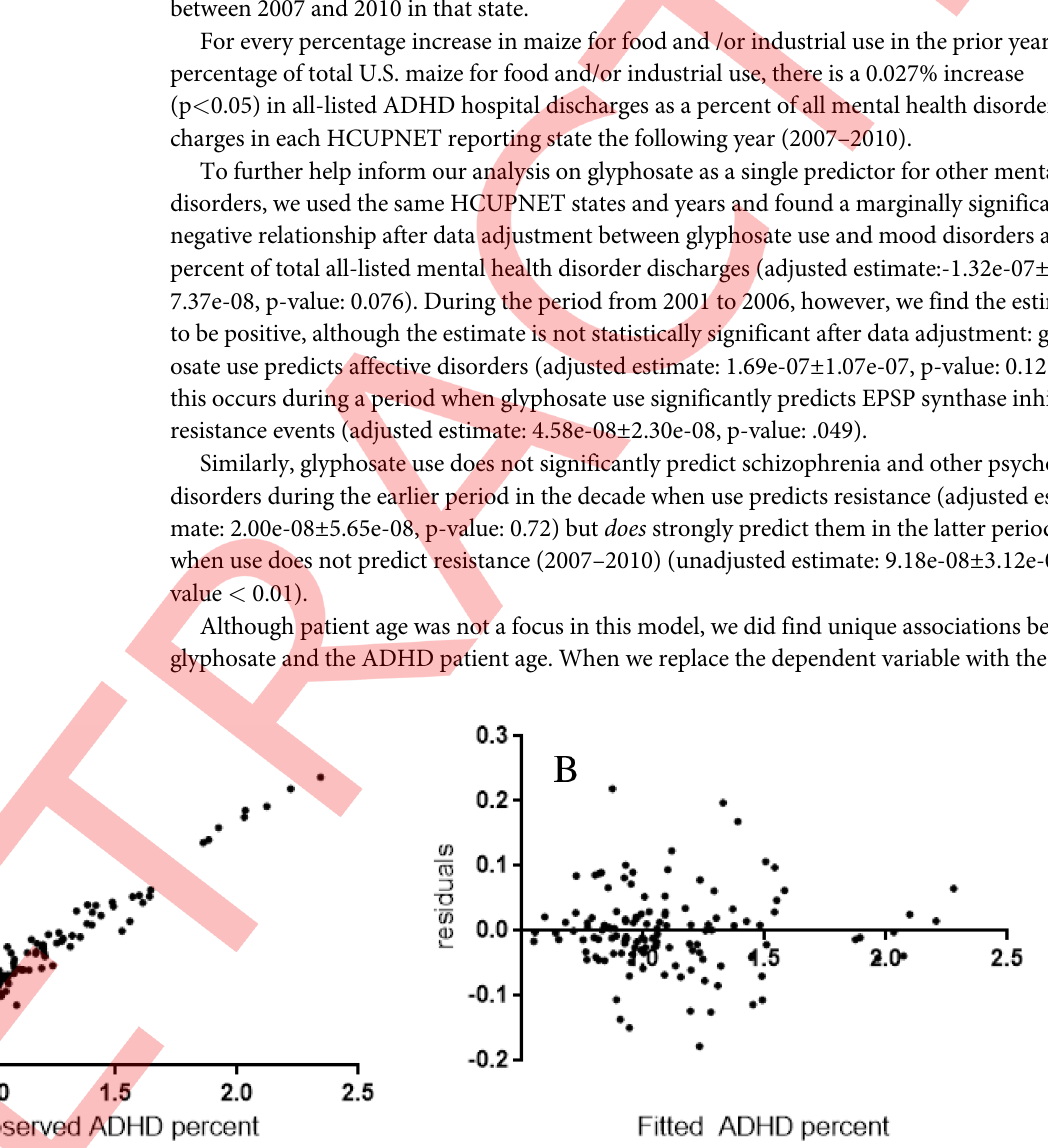
Fig 5. Diagnostic plots for Model 1 show marked heteroskedasticity within the center of distribution. (A) Observed all-listed ADHD percent discharges ( N 1 = 127) plotted against predicted percentages (B) Model residuals were plotted against fitted values. Fitted values were tabulated in R by subtracting residuals from observed